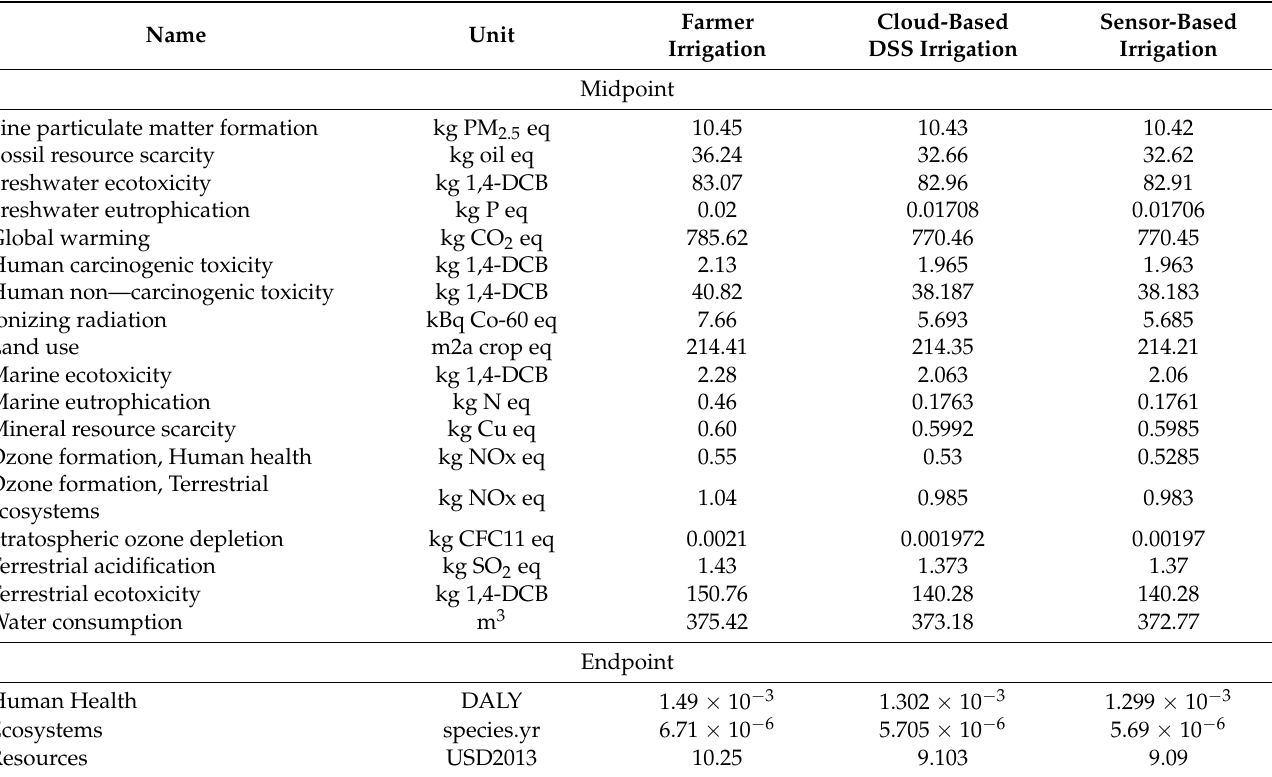
Table 4. Environmental impacts attributed to 1-ton zucchini product using farmer experience and soil-moisture irrigation-based